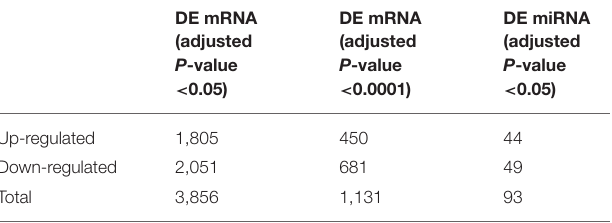
TABLE 1 | Summary of differentially expressed mRNAs and